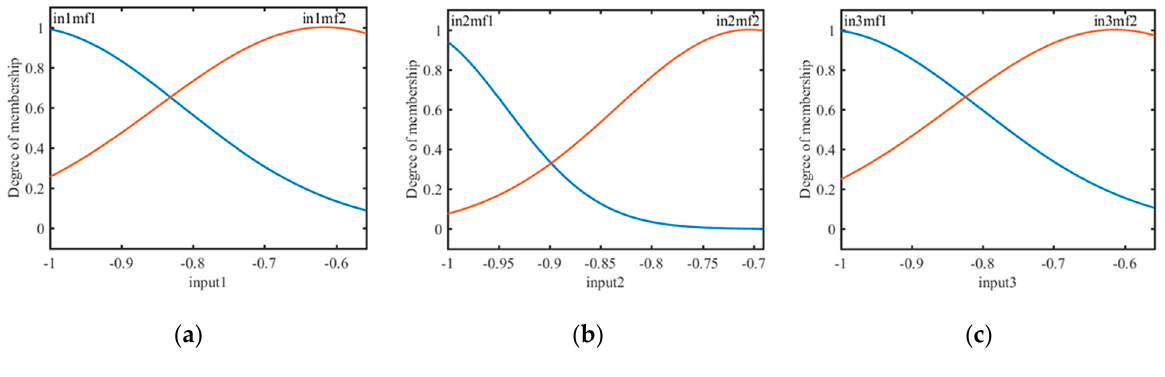
Figure 9. Membership functions for ( a ) R ( t ), ( b ) R ( t -1), and ( c ) R ( t -2).